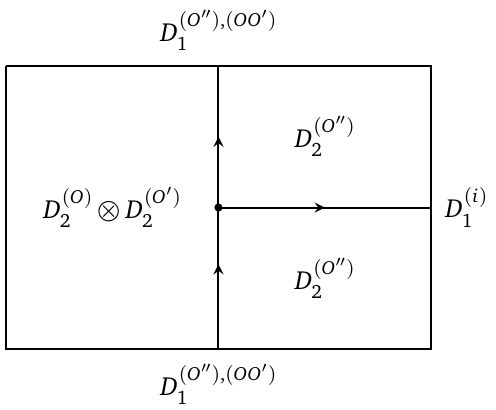
Figure 24: The coefficient n appearing in (52) is the dimension of the vector space i of local operators shown in the